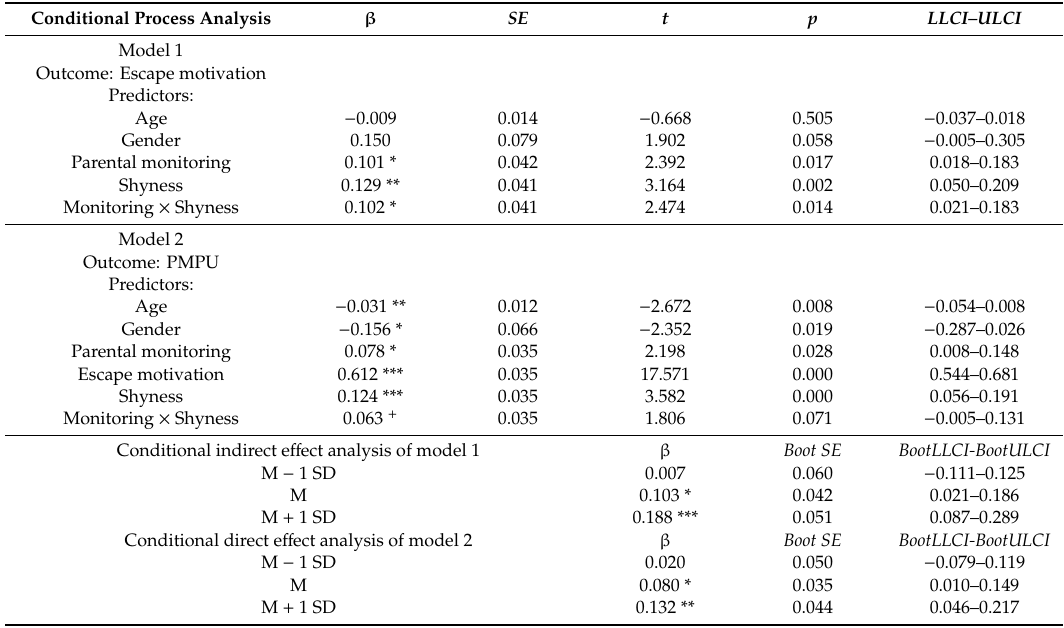
Table 2. Bootstrap test on moderated mediation e ff